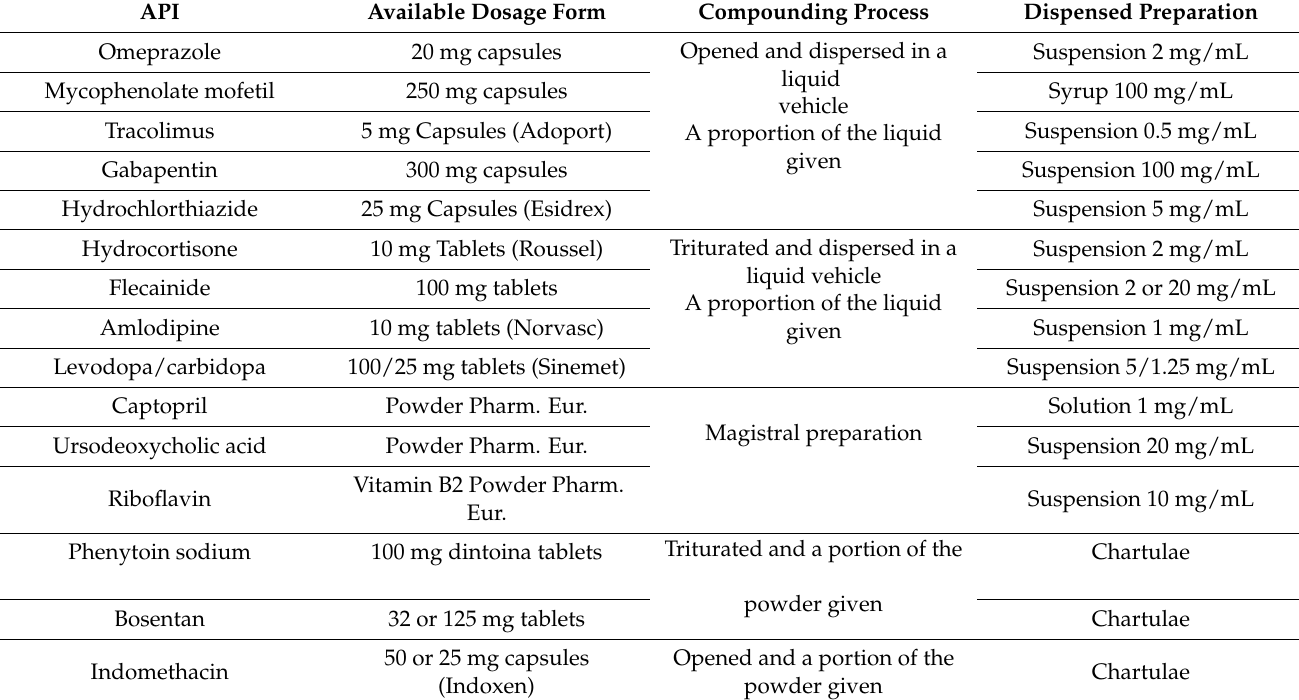
List of oral drugs routinely manipulated in pediatric practice by the G. Gaslini Hospital